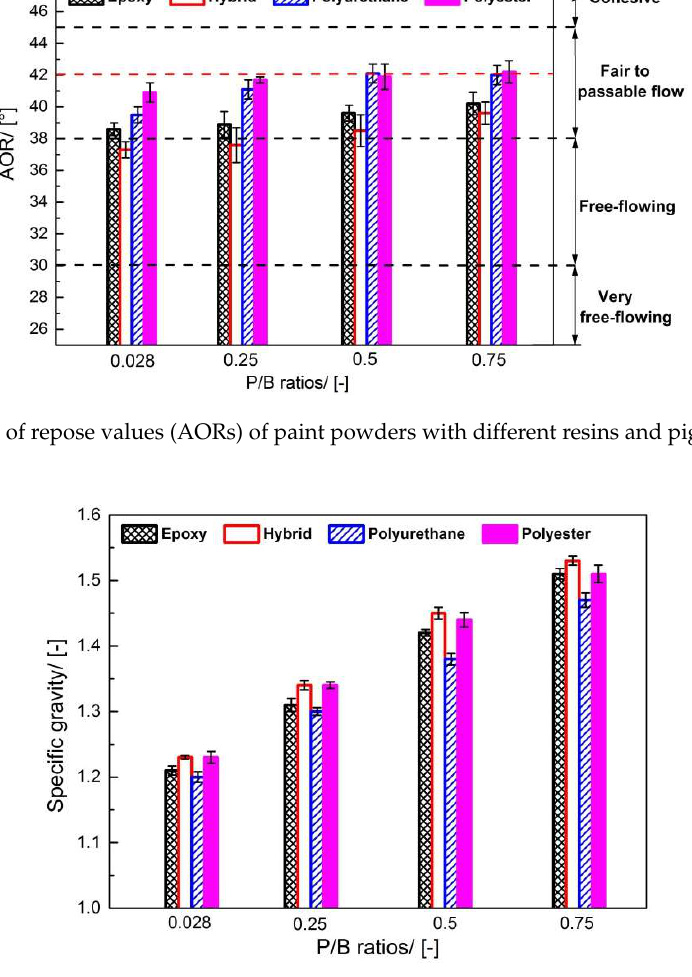
Figure 2. Specific gravities of formulations with different resins and P/Bs.